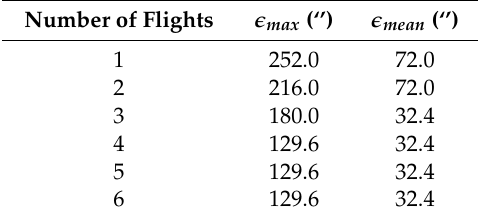
Table 7. Misalignment error as a function of number of flights around the VOR station.